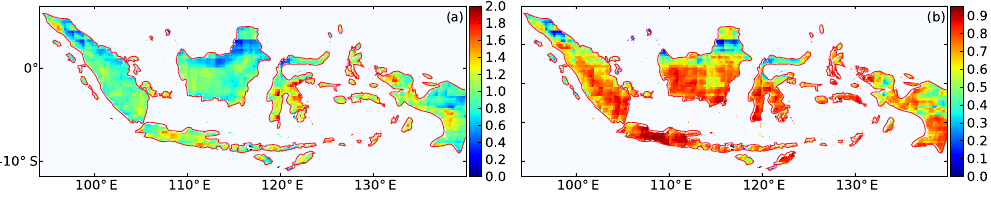
Figure 2. (a) Slope and (b) R 2 of a linear regression between GPCP and TRMM rainfall based on the cumulated rainfall for the 4 driest months between 1998 and